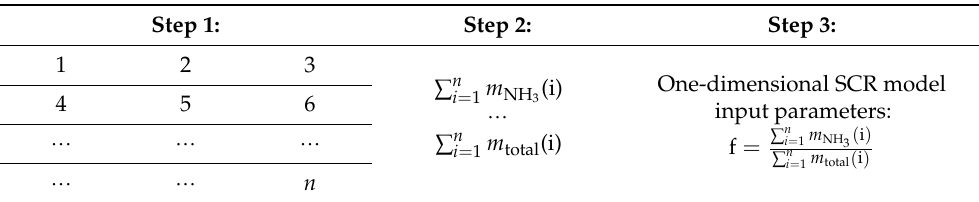
Table 7. The main steps of transforming the output data of three-dimensional CONVERGE engine model into input parameters of the one-dimensional SCR aftertreatment model.